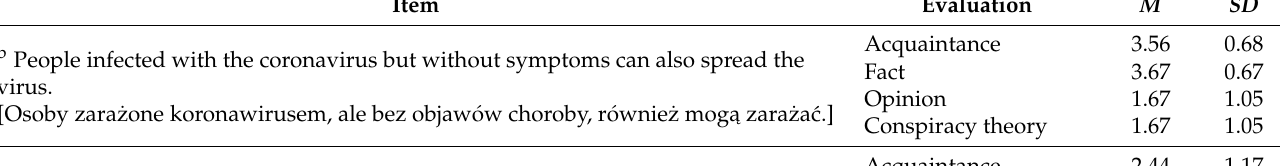
Table A1. Cont. Item Evaluation